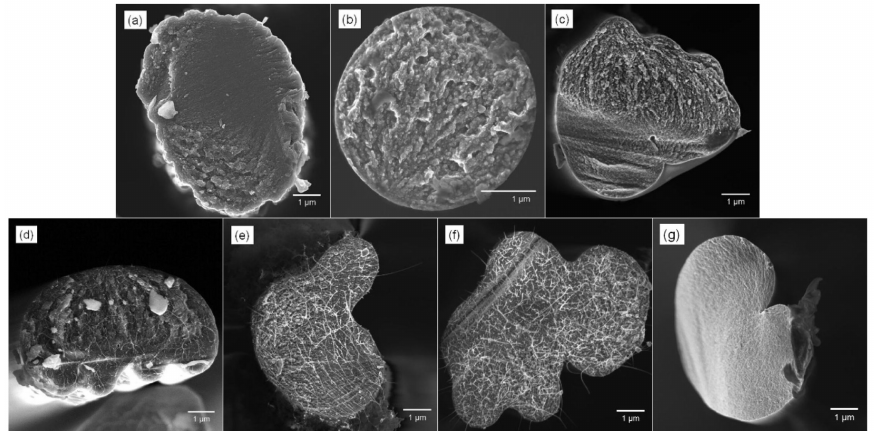
Figure 12. SEM of various carbon fibre cross sections ( a ) T300, ( b ) IM7, ( c ) GT PAN, ( d ) GT PAN/CNT- A (0.42 wt%), ( e ) GT PAN/CNT-B1, ( f ) GT PAN/CNT-A, and ( g ) GT PAN/CNT-C (see reference [45] for further details).